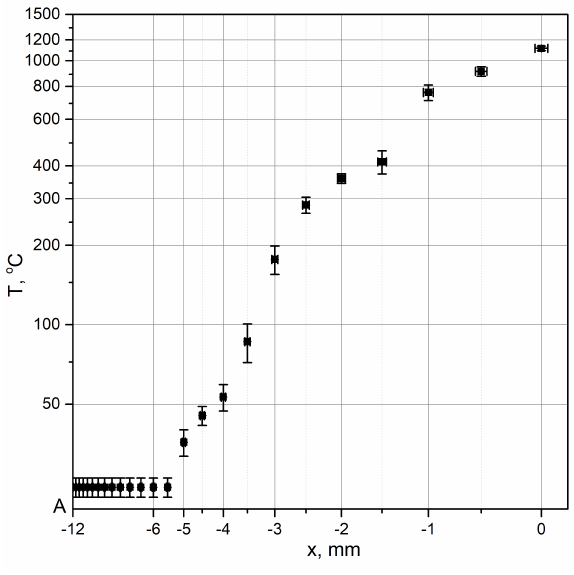
Figure 6. Temperature measured on line